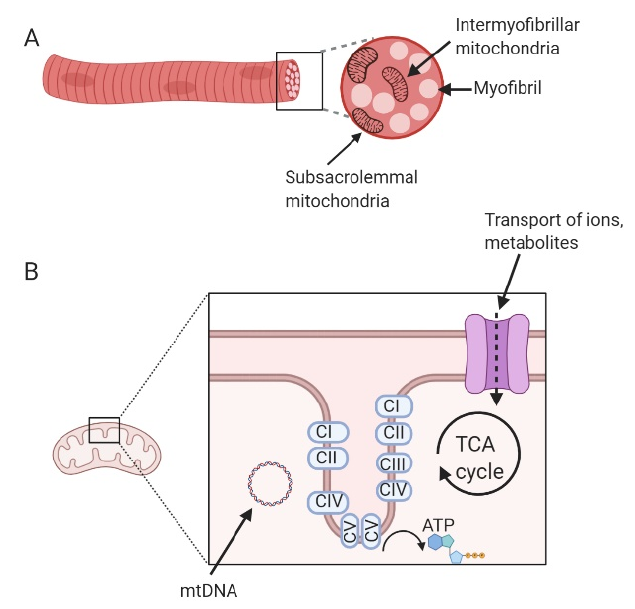
Figure 1. ( A ) Location of mitochondria within the skeletal muscle fibre. ( B ) Location of metabolic processes within the mitochondria. Black boxes indicate a section of each figure that has been magnified in the right-hand image. Created with BioRender.com.